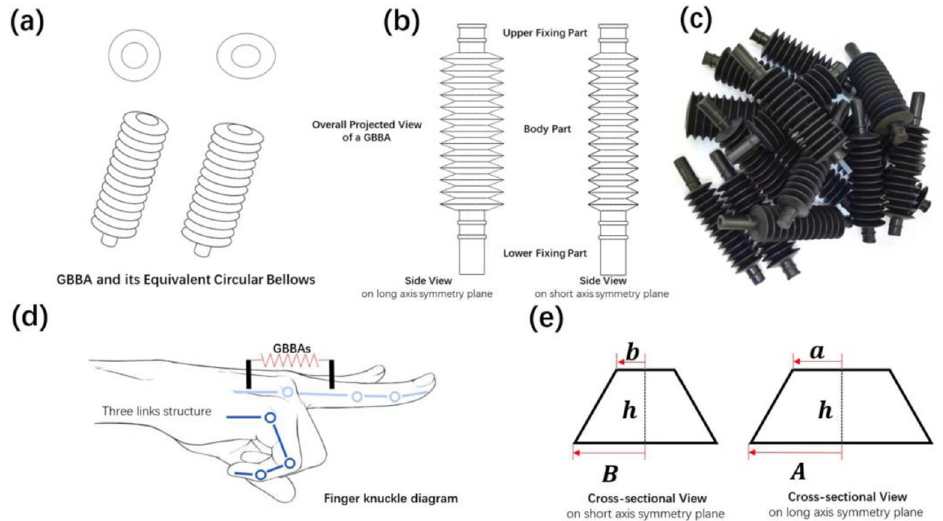
Figure 2. Geometric design of a GBBA: ( a ) the oval table serves as the minimum folding movement section in a GBBA; ( b ) comparison of the appearance and structure of the equivalent circular bellows and GBBA; ( c ) overall appearance of the GBBA; ( d ) schematic diagram of the working principle of the GBBA; ( e ) double symmetry planes of the GBBA folding unit.